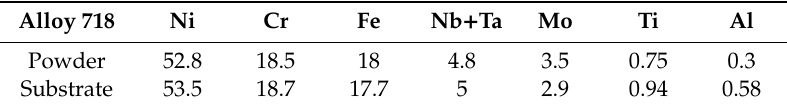
Table 1. Chemical composition of Alloy 718 powder and substrate